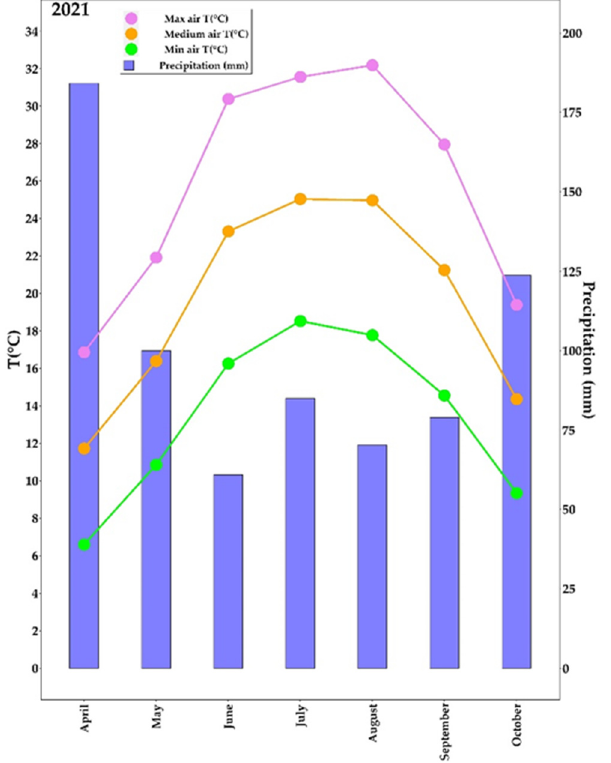
Figure 1. Meteorological parameters of the experiment location. Monthly averages of mean, maximum, and minimum air temperature ( ◦ C) and precipitation (mm) were measured from April to